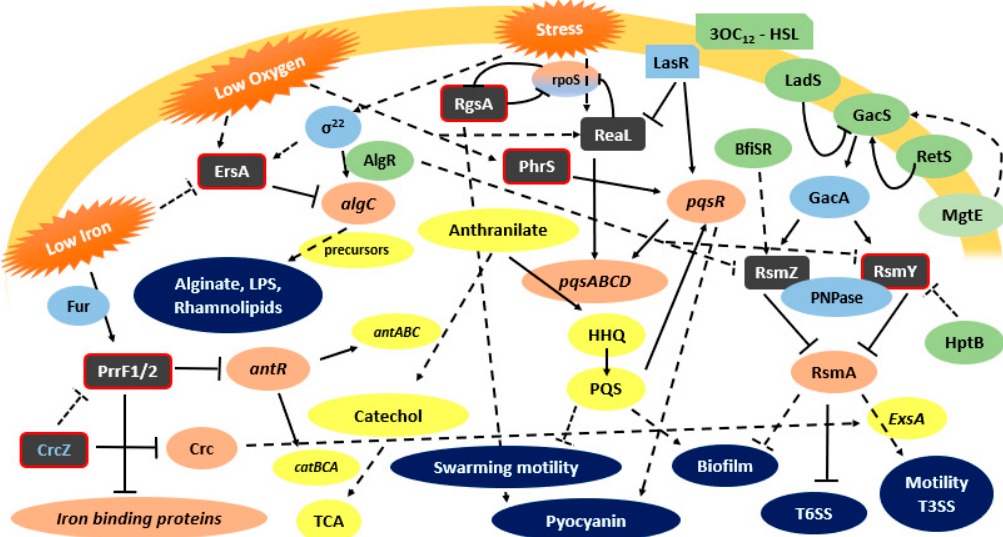
Figure 1. P. aeruginosa functionally characterized sRNAs and their involvement on virulence regulatory pathways. Grey box—characterized sRNAs (with red border- Hfq biding); Green box—indirect regulator, Light Blue box—direct regulator; Coral box—direct target; Yellow box—indirect target; Dark Blue—virulence factors; ↓ : positive control; ⊥ : negative control; dashed lines: indirect control.